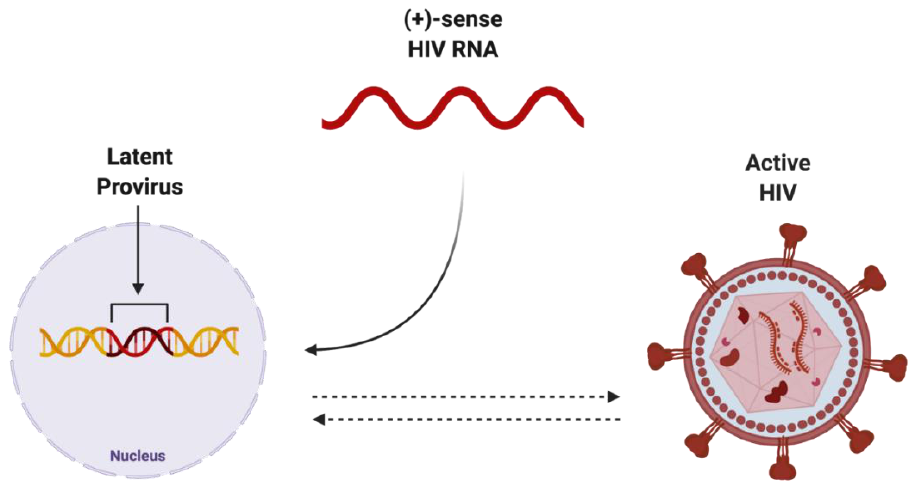
Figure 3. Potential endpoints of positive-sense HIV RNA after integration into host genome. Once integrated into the host genome, (+)-sense HIV RNA can persist as either latent provirus, which is capable of being reactivated, or actively replicating HIV, which can be deactivated. Created with BioRender.com. Abbreviations: (+)-sense = positive-sense; HIV = human immunodeficiency virus; RNA = ribonucleic acid.